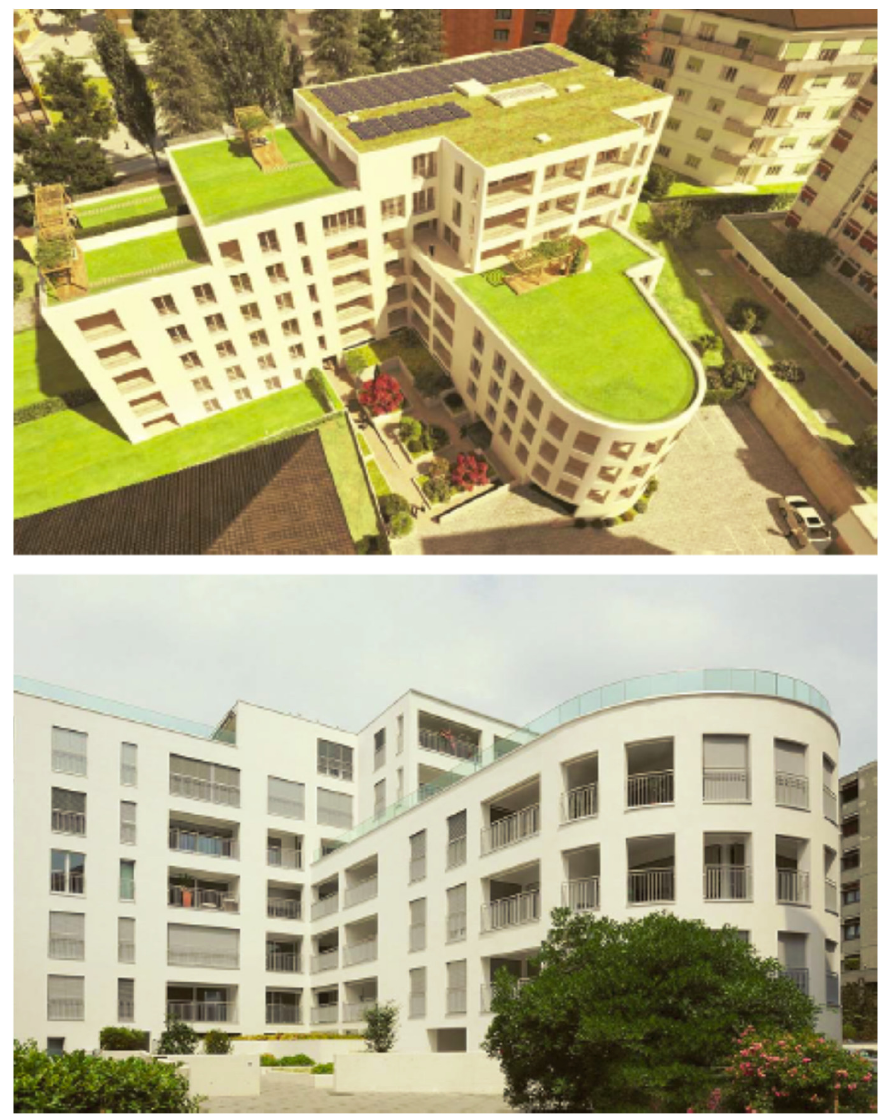
Figure 2. Rendering ( top ) and photograph ( bottom ) of the building located in the densely populated centre of Lugano (source: [22]).